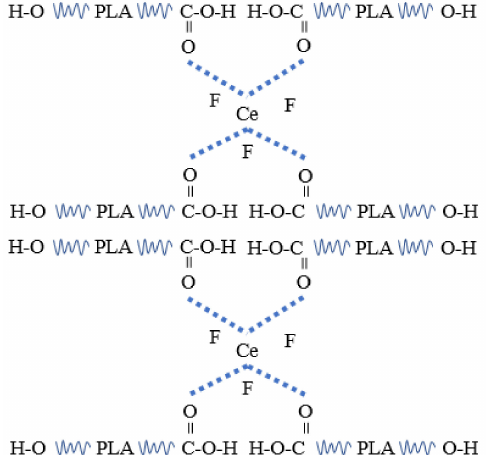
Figure 9. Schematic diagram of the interaction between CeF 3 and PLA.